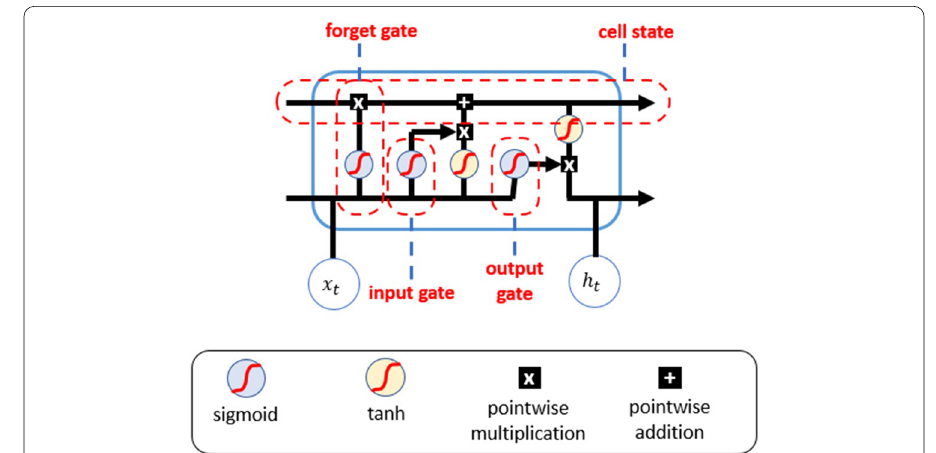
Fig. 2 LSTM cell and its gates mechanism